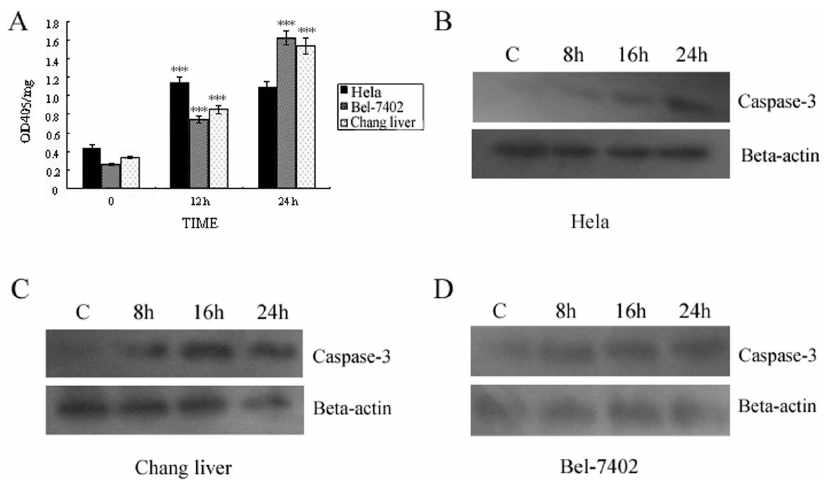
Figure 4. Activation of Caspase-3 induced by T-2 toxin. A . Detection of Caspase-3 hydrolase activity under T-2 toxin stress. B . Western blot result of Caspase-3 activated fragments in Hela cells when treated with T-2 at the concentration of LC50 for 8, 16, and 24 h respectively. C . Western blot result of Caspase-3 activated fragments in Changliver cells. D . Caspase-3 activity in Bel -7402 cell. Data was presented as mean 6 SD. *p , 0.05, **p , 0.01, ***p , 0.001.